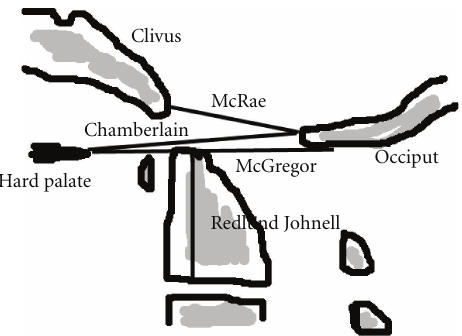
Figure 1: Basilar invagination is present when the odontoid tip is > 6mm above the Chamberlain’s line; above McRae’s line; > 8mm above McGregor’s line in males and > 9.7mm above this line in females; or when the Redlund-Johnell distance is < 34mm in males and < 29mm in